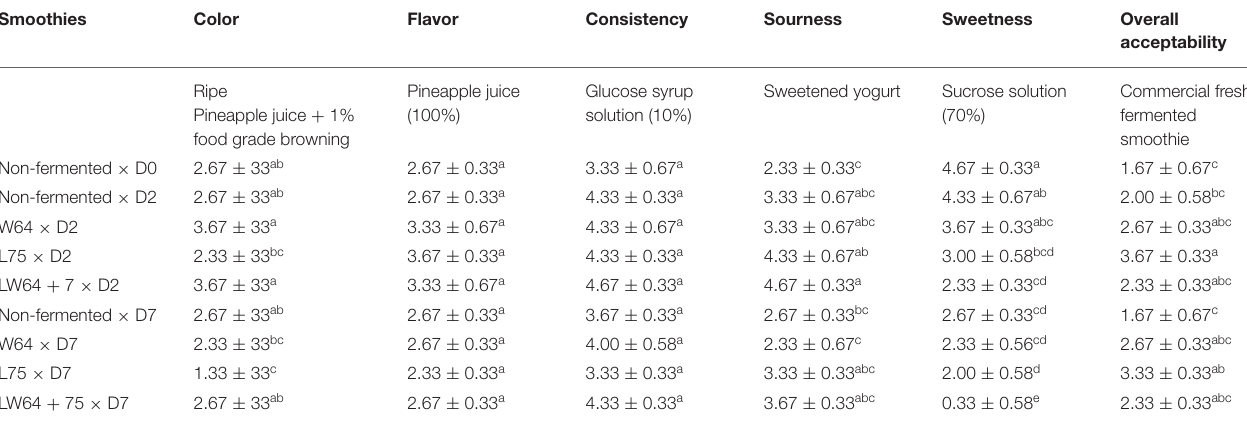
acceptability Pineapple juice Glucose syrup Sweetened yogurt Sucrose solution Commercial fresh (100%) solution (10%) (70%) fermented smoothie